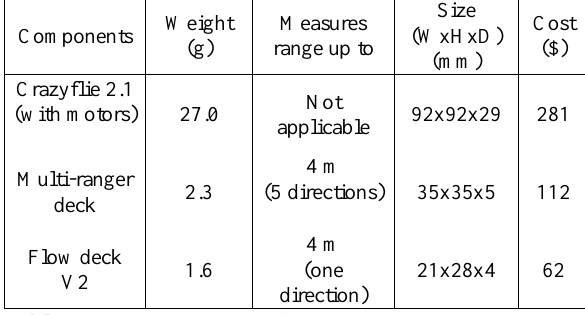
Table 1 . The Bitcraze Crazyflie 2.1 microdrone with its